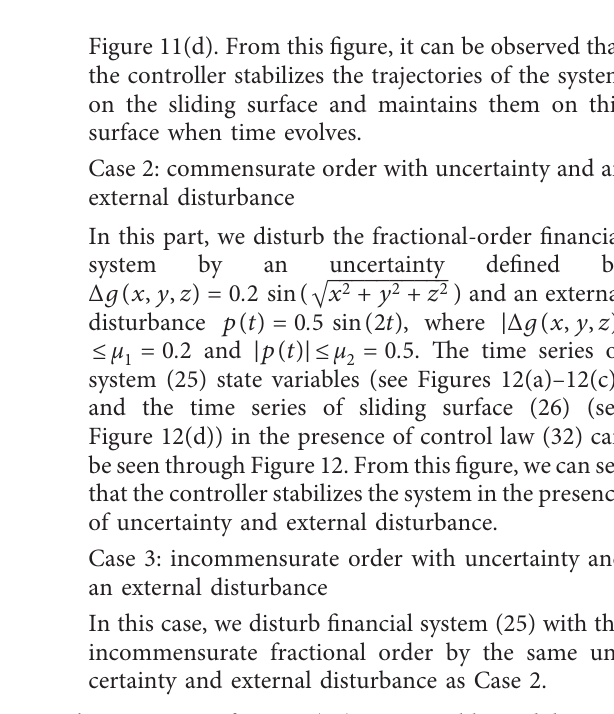
Figure 10: Phase diagrams and time series of system (6) with q (b) projected onto the x − z phase plane, (c) time series of x , and (d) time series of y